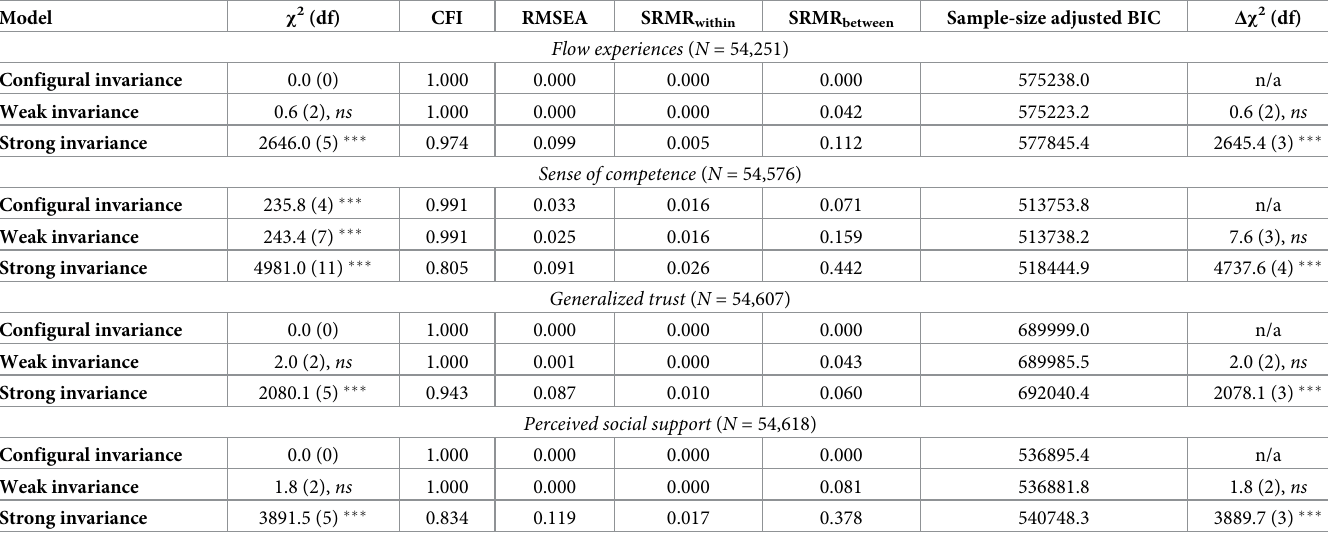
Table 3. Results from ML estimation of measurement